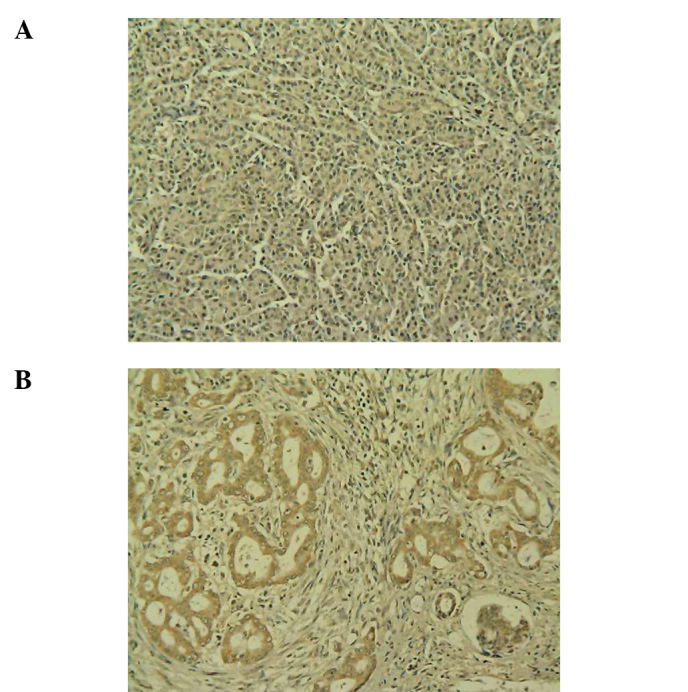
Immunohistochemical staining for ApoE. (A) Low ApoE expression in normal pancreatic tissue. (B) High ApoE expression in pancreatic cancer tissue (magnification, ×200). ApoE, apolipoprotein E.